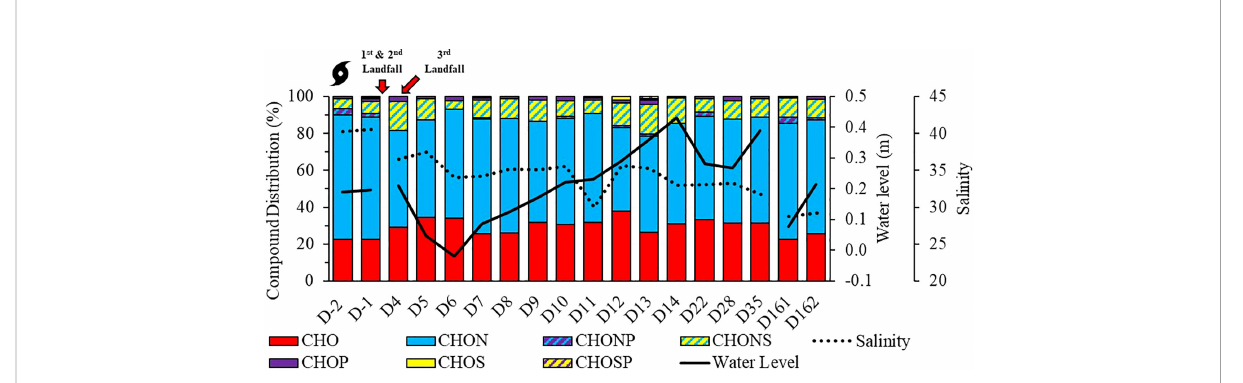
FIGURE 5 Pre-landfall (e.g., D-2 and D-1) and post-landfall (e.g., D4 – D35, D161, and D162) surface water DOM molecular composition and percent presence with assigned formulas in relation to bay water level and salinity. DOM, dissolved organic